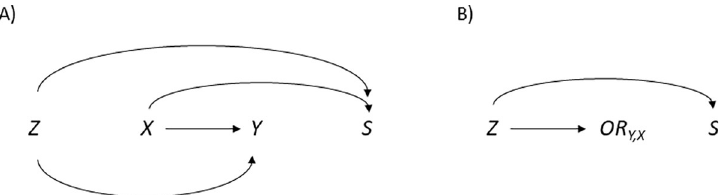
Fig 3. Directed acyclic graphs (DAGs) showing how selection bias can arise. Panel A displays an example of collider bias (where estimates from the sample lack causal interpretation), whereas panel B displays an example of causal effect heterogeneity (where the effects are inherently different across participants and the full